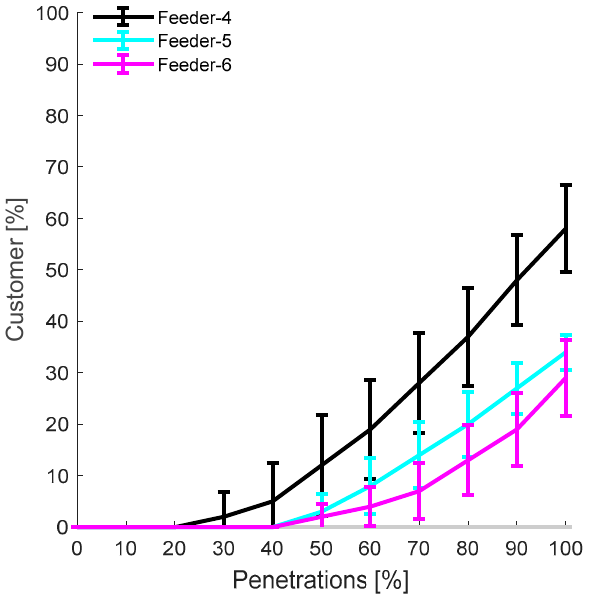
Figure 4. Percentage of customers with voltage rise problem.